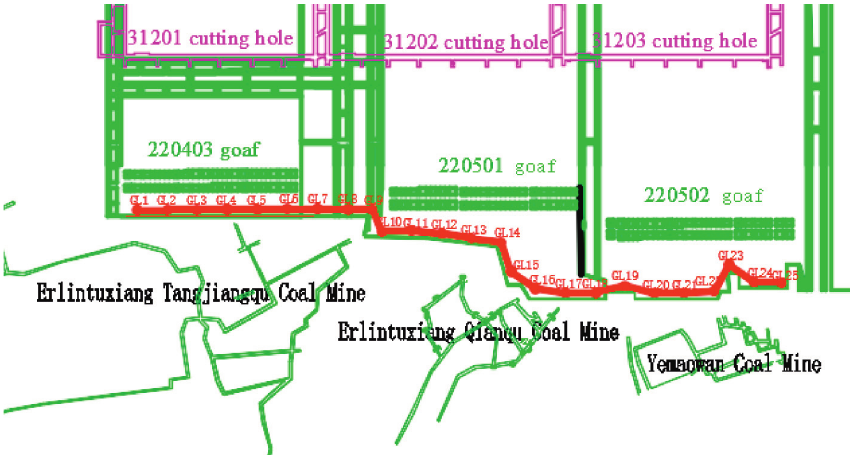
Figure 11: Construction of the isolation zone.